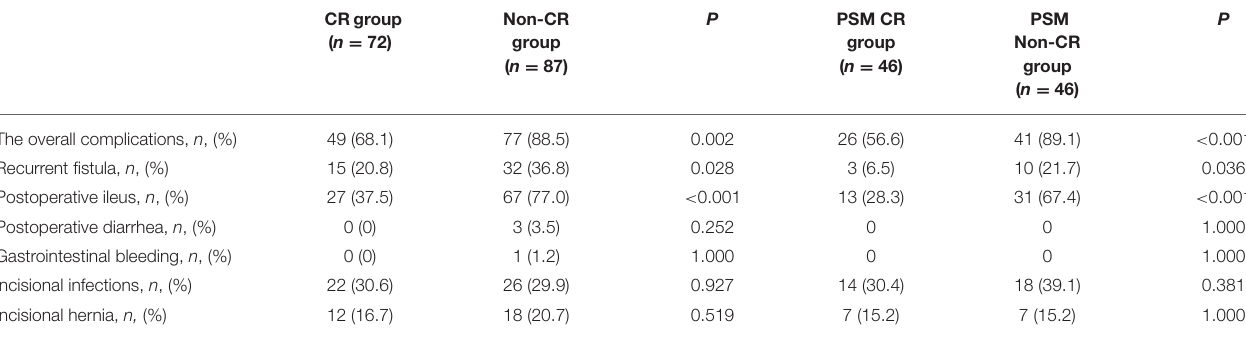
TABLE 4 | Incidence of the